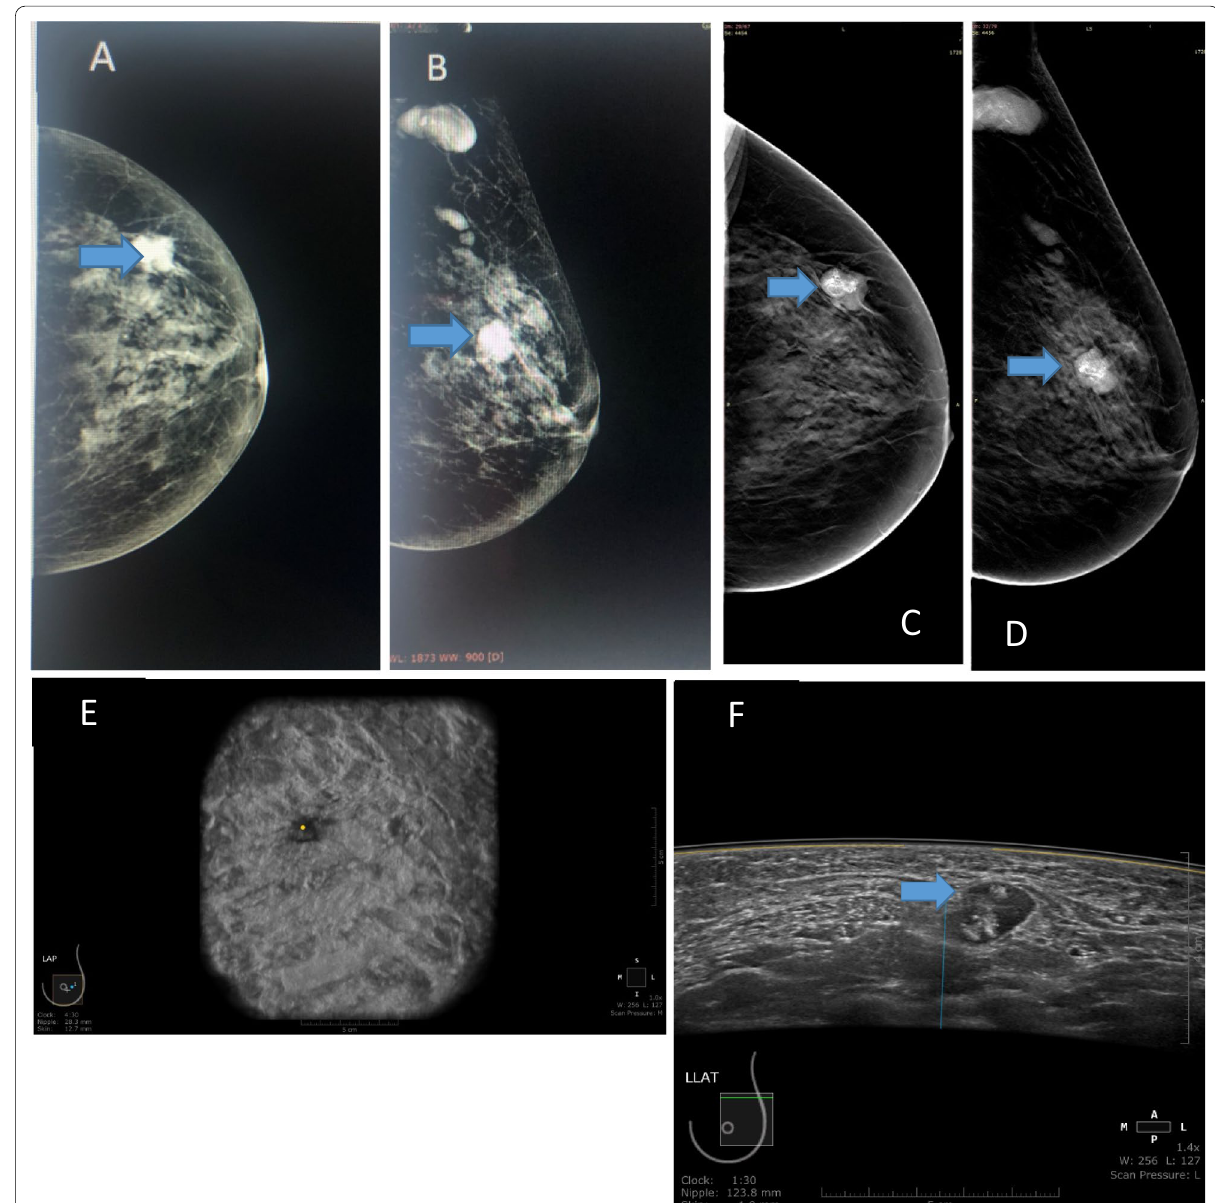
Fig. 4 A and B : Digital Mx CC and MLO views of the right breast show an oval-shaped circumscribed high-density UOQ mass with no associated skin thickening. C and D : Tomosynthesis CC and MLO views of the right breast confirmed the mammographic findings, however, with better delineation of the margins (BIRADS IV). E : Automated ultrasound right AP coronal image shows small focal defect at distance 28.3 mm from the nipple. F : Automated ultrasound image shows a right rather well-defined mass, non-parallel orientation and heterogeneous echo pattern (BIRADS V). Core biopsy was done and revealed adenocarcinoma. Automated ultrasound was superior to tomosynthesis in characterization of the lesion, while tomosynthesis was superior in detection of right axillary